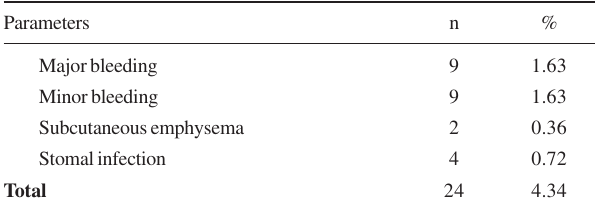
Table 1 - Complications of open bedside tracheostomy (OBT) (up to 30 days postsurgery) Parameters